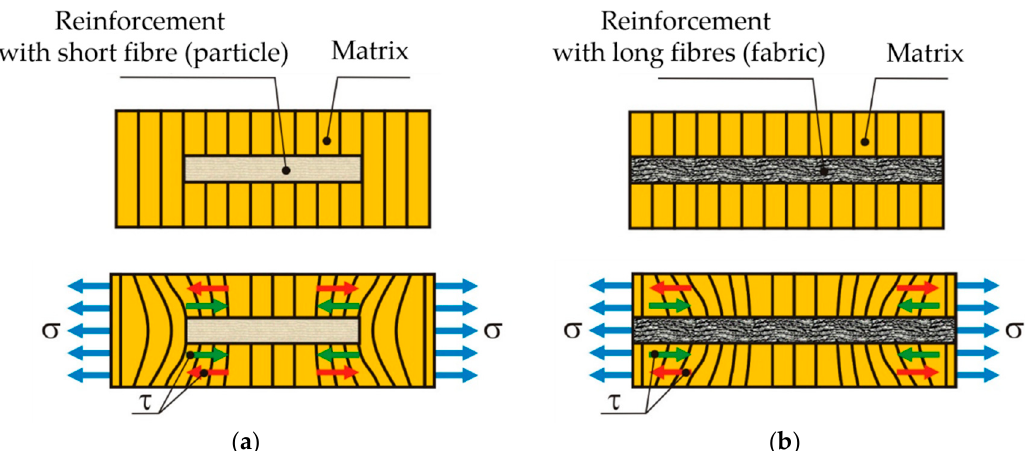
Figure 16. Mechanism of failure modes: ( a ) the case of short fibres reinforced composites; ( b ) the case of long fibres reinforced composites.